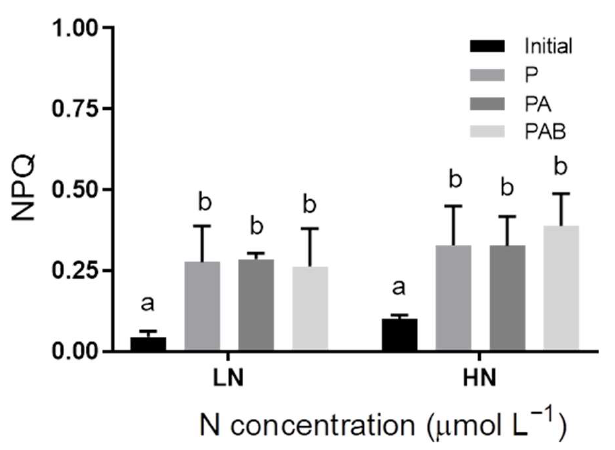
Figure 4. Non-photochemical quenching (NPQ) of Sargassum horneri under P, PA, and PAB treatments. Significant differences among all treatments are indicated by different lowercase letters ( p <